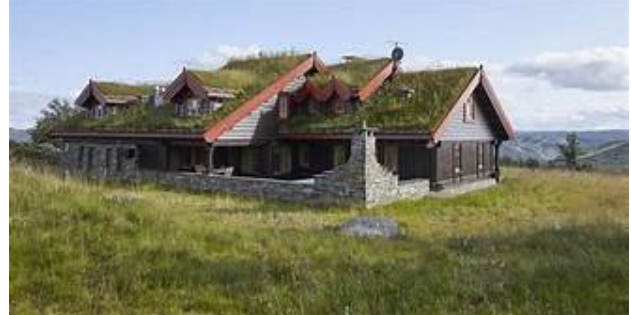
Figure 14. The house above uses vegetation on the roof to provide energy conservation.